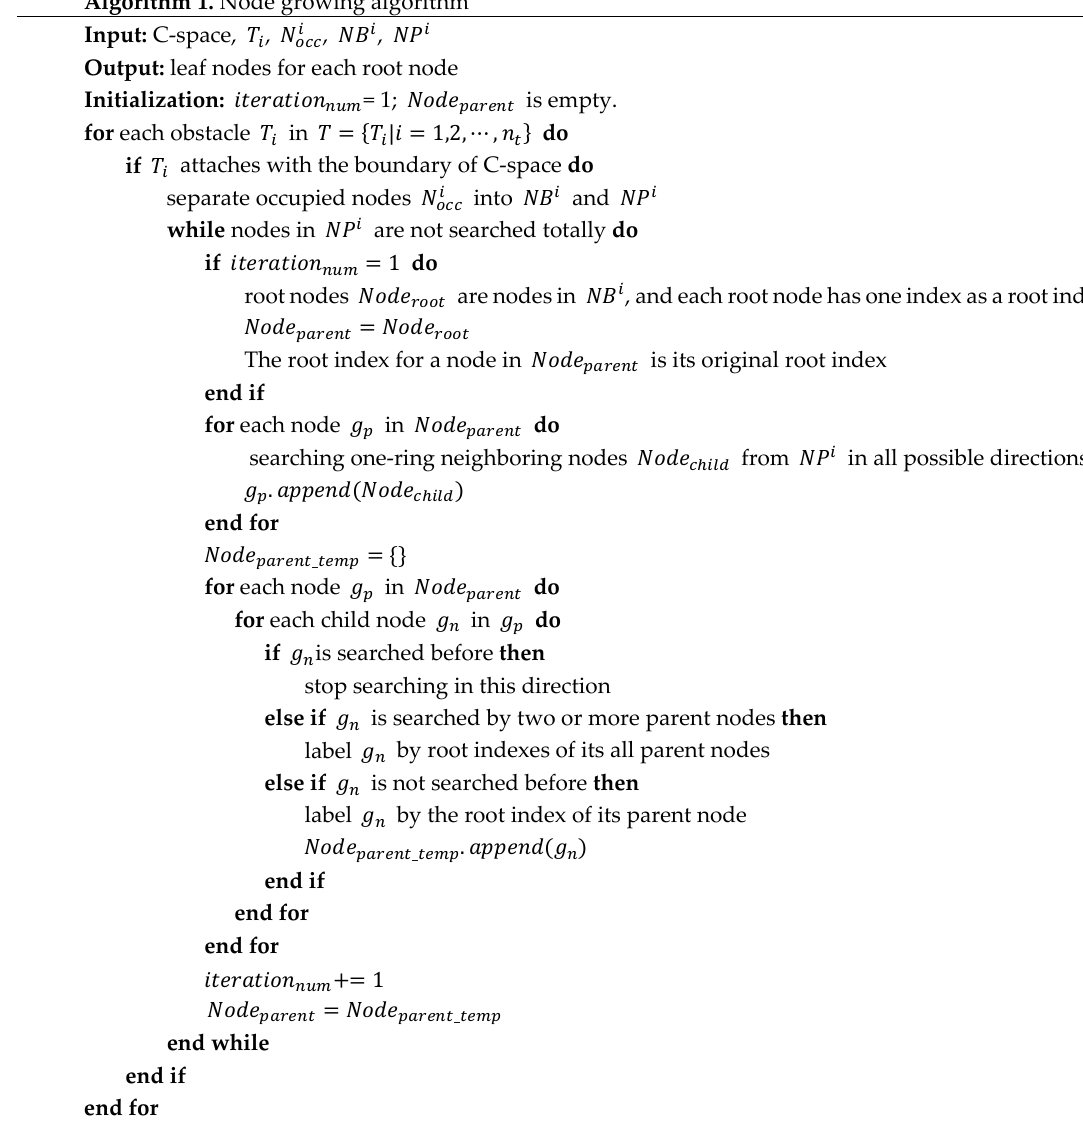
Figure 9. The process of iterations for growing from root nodes. The number in the picture is the index of the root node. The child nodes grow in the same iteration are in the same color. Algorithm 1. Node growing